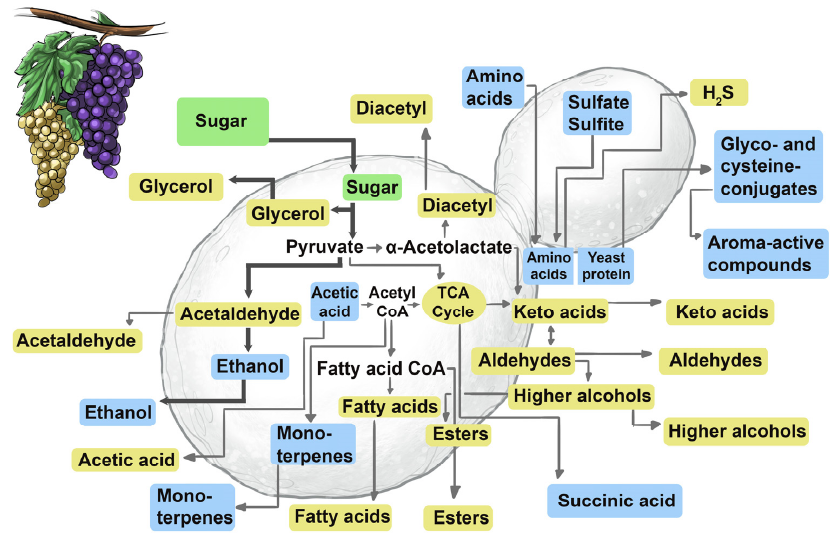
Figure 12. The derivation and synthesis of flavour ‐ active compounds from sugar, amino acids and sulfur metabolism by wine yeast (adapted from [7]). Different strains of wine yeast possess different abilities to form and modulate chemical compounds that affect wine sensory properties.